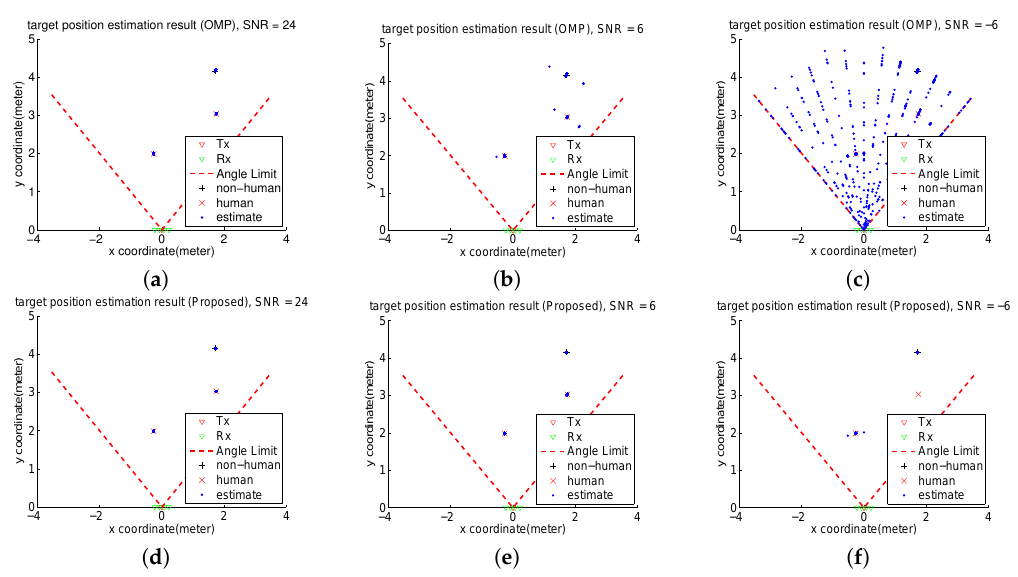
Figure 7. The compressive sensing (CS) radar scenes using the OMP reconstruction in ( a ) 24 dB, ( b ) 6 dB, and ( c ) − 6 dB SNR environments. The CS radar scenes using the two-stage OMP reconstruction in ( d ) 24 dB, ( e ) 6 dB, and ( f ) − 6 dB SNR